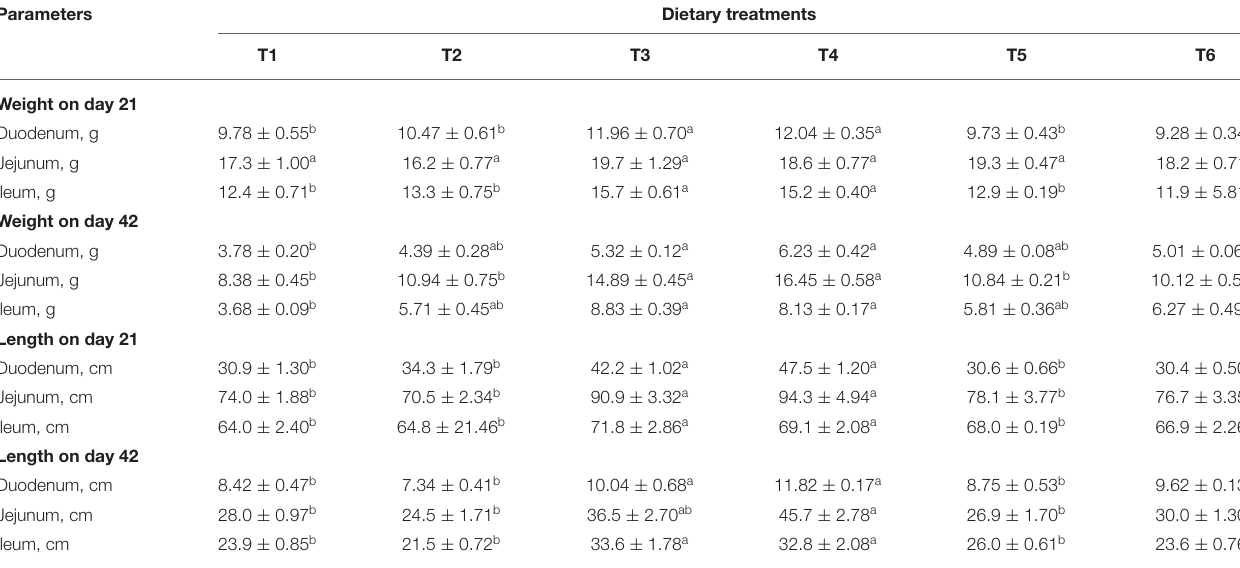
TABLE 4 | Effect of different dietary treatments on weight (g) and length (cm) of duodenum, jejunum and ileum of broilers ( n = 6 chicks per treatment, mean ± SE). Parameters